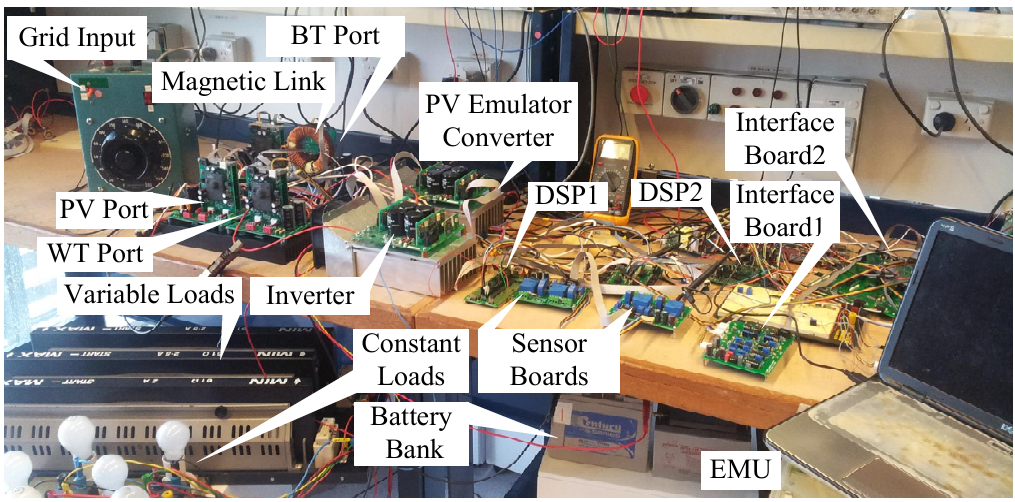
Figure 12. The experimentally developed multi-port converter.